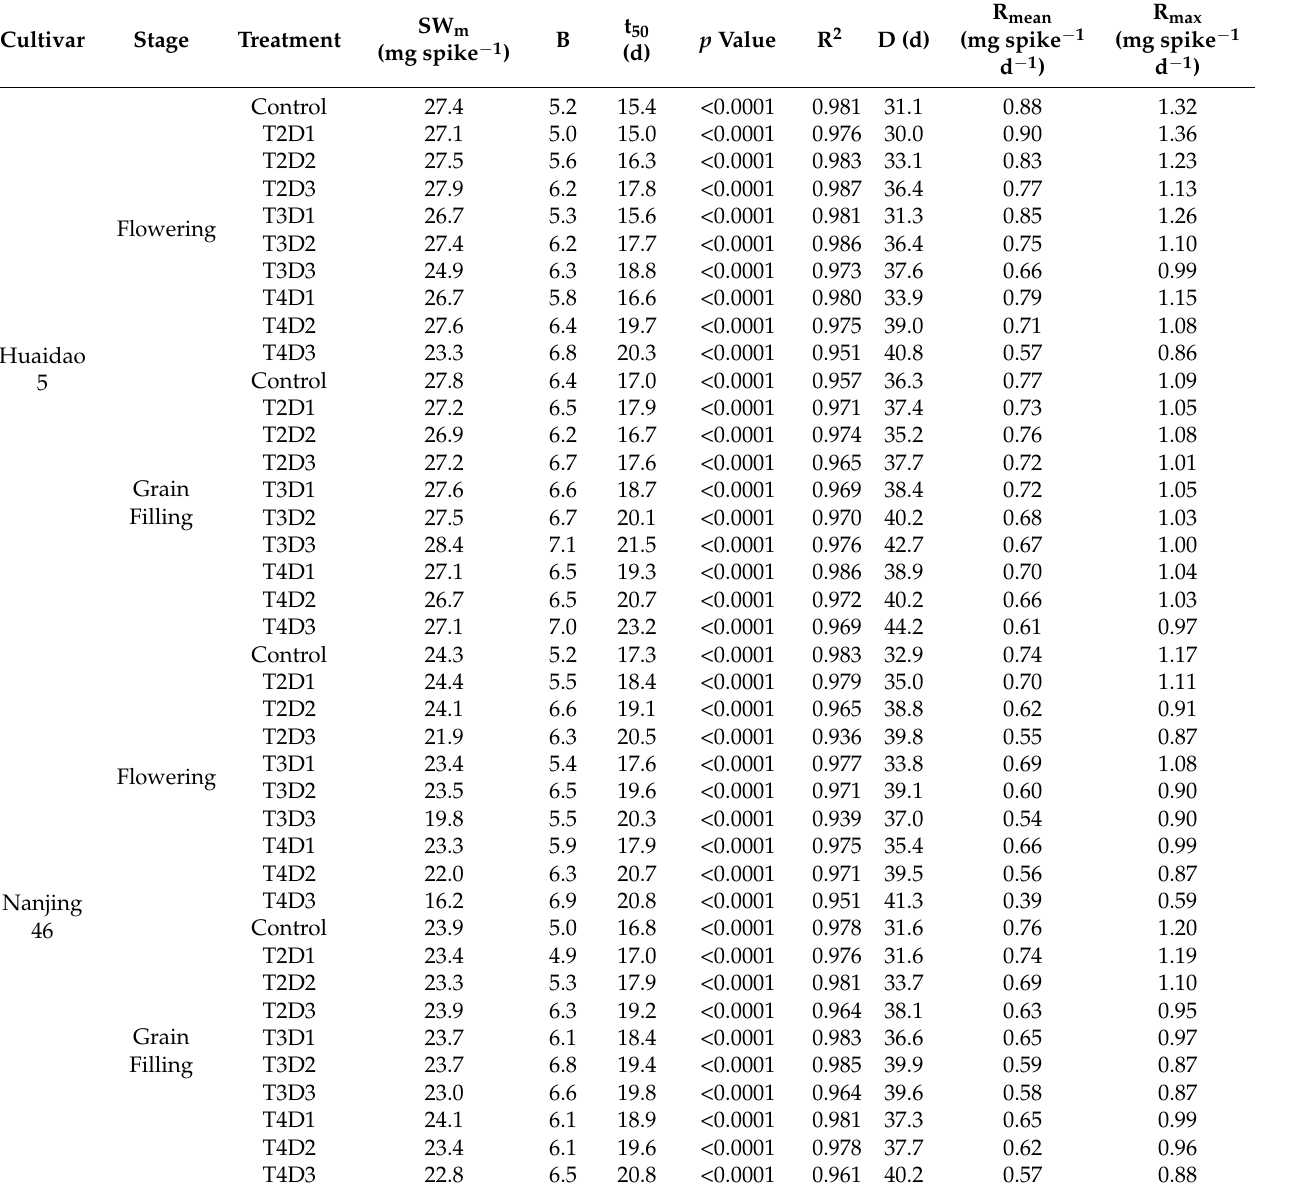
Table 2. The effect of post-heading low-temperature stress (LTS) on grain filling related parameters.